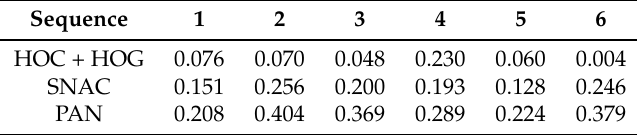
Table 3. Discriminations of different features on tracklets.